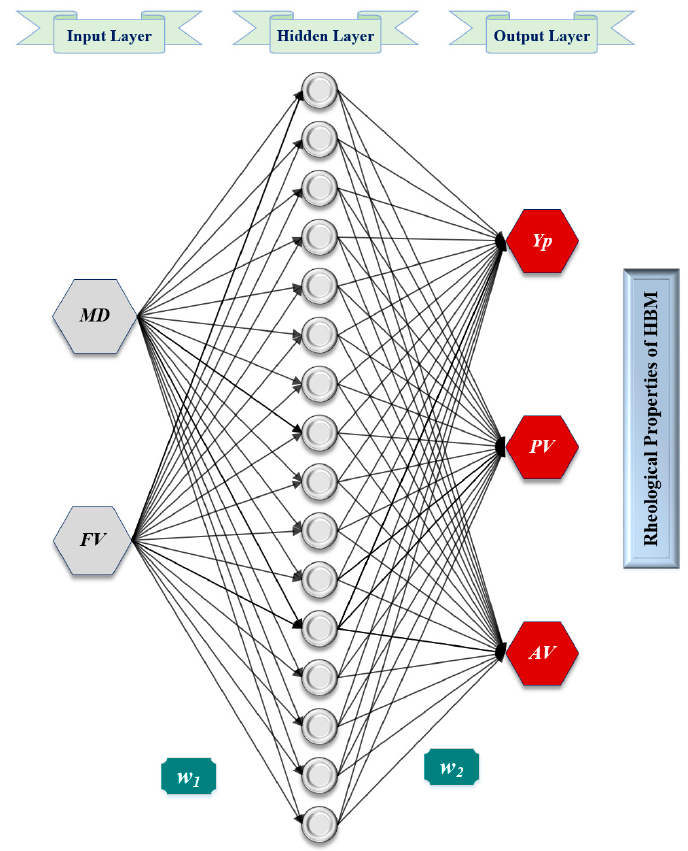
Figure 3. Flowchart describing the workflow of developing the ANN models.